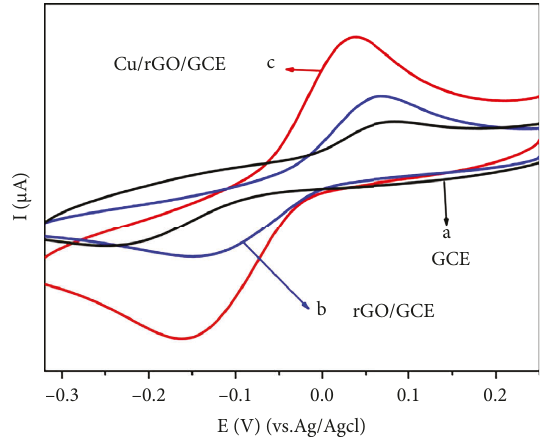
Figure 4: Nyquist plots of GCE, rGO/GCE, and Cu/rGO/GCE in 1.0mM [Fe(CN) 6 ] 3 − /4 − solution, inset: equivalent circuit.